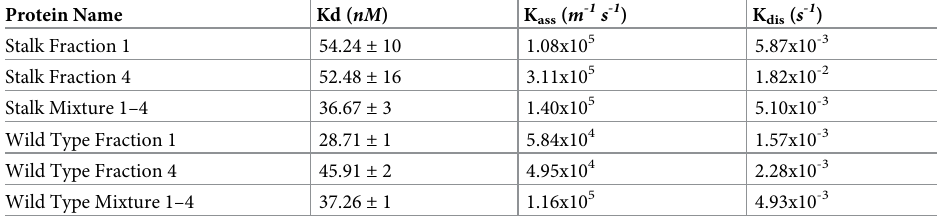
Table 1. Binding parameters for the association of wild type N protein and its stalk domain with the 5’ UTR of S- segment derived